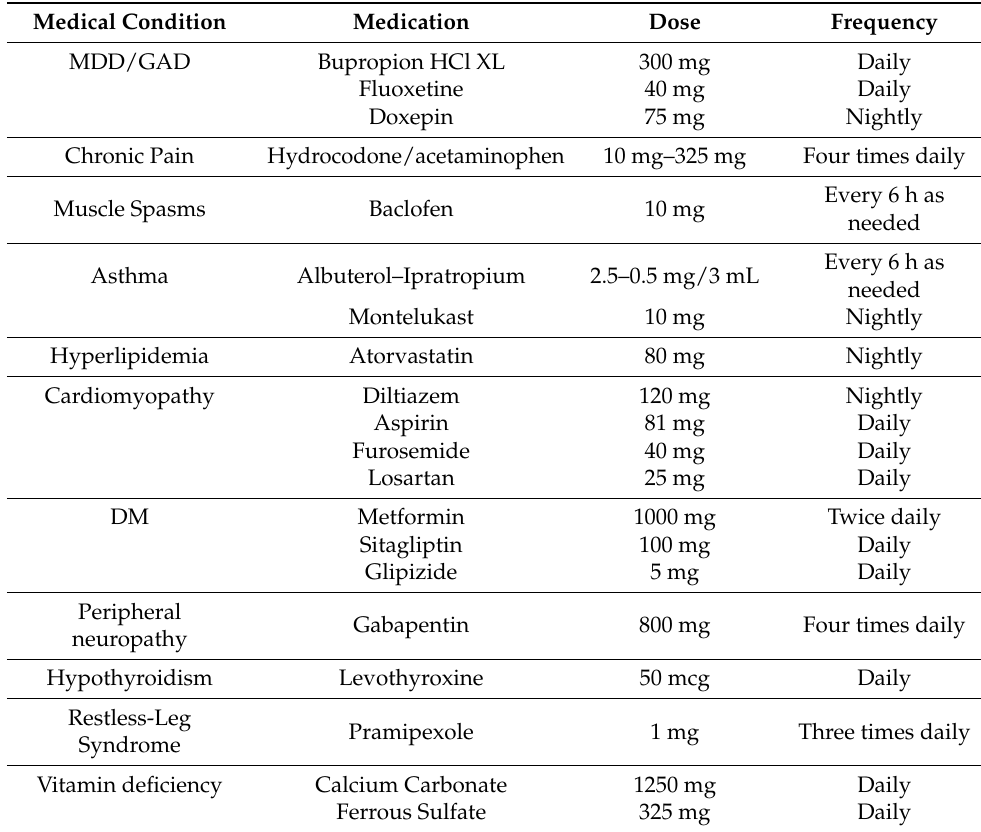
Table 1. Medications at the time of the fall.